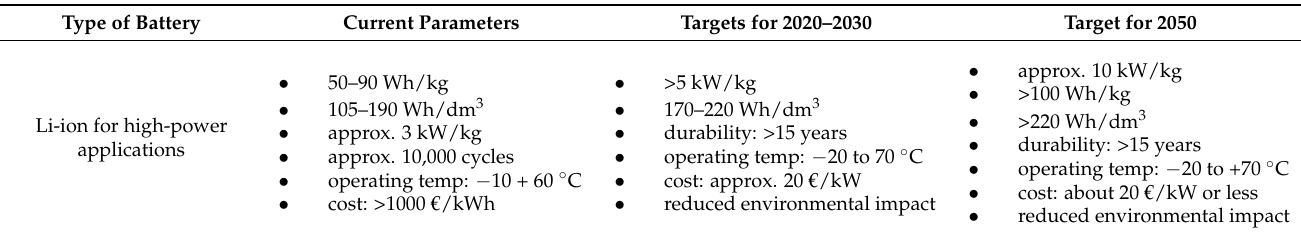
Table 1. Development goals of energy storage based on Li-ion batteries